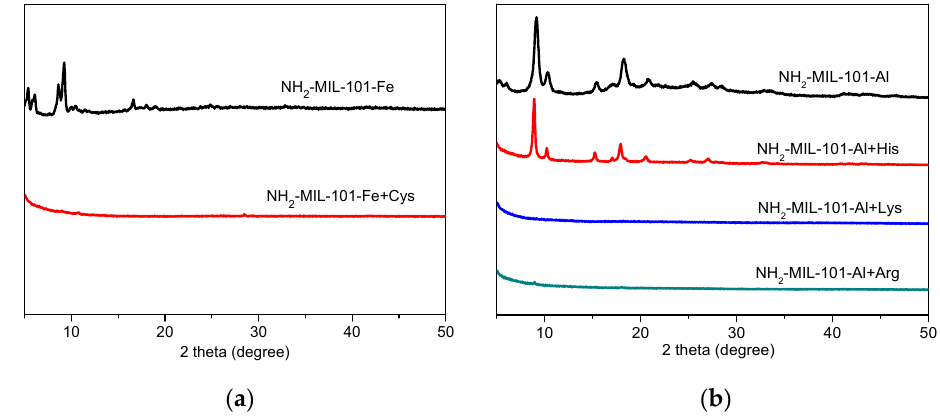
Figure 4. PXRD data of NH 2 -MIL-101-Fe ( a ) and NH 2 -MIL-101-Al ( b ) before and after soaking in the aqueous solution of Cys and Lys/Arg/His.